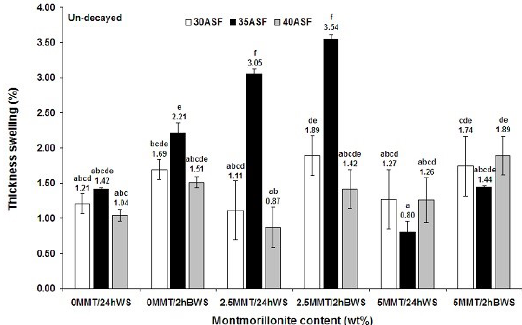
Figure 6. The average and standard errors for the thickness swelling measurements (2 h boil water soaked and 24 h water soaked) measurements of the un-decayed